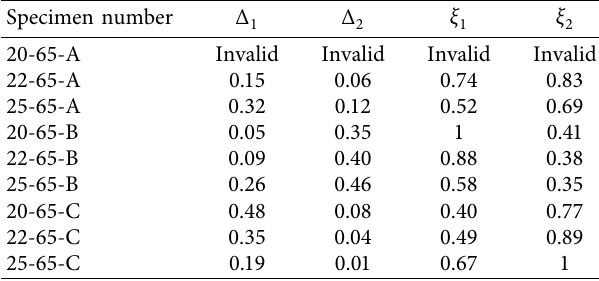
Table 6: Sequence proximity and correlation coefficient.